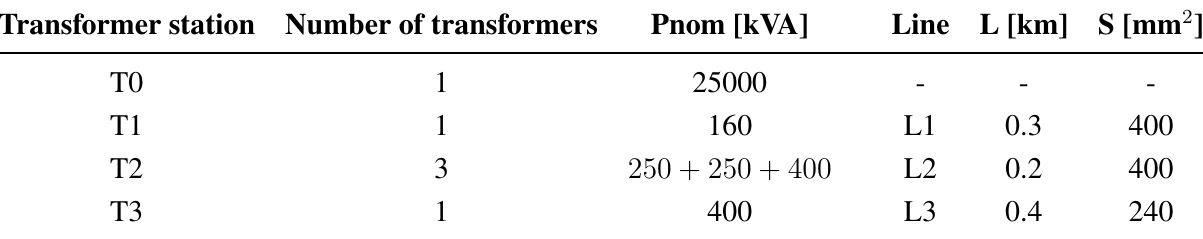
Table 5. Features of the elements used in the studied